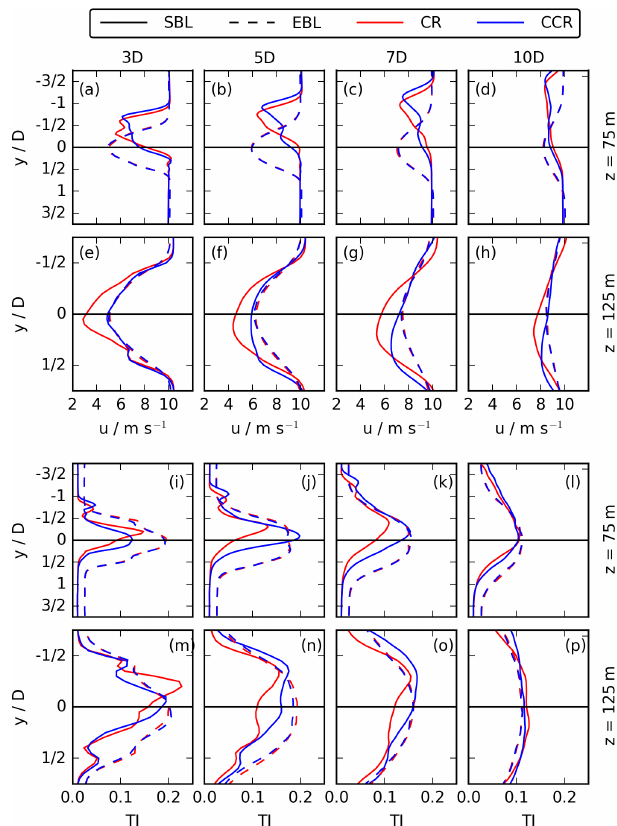
Figure 12. Spanwise profiles of u (first two rows) and TI (last two rows) at z = 75m in the first and third rows and at z = 125m in the second and last rows for the SBL and the EBL wind-turbine simulations at x = 3D (first column), 5D (second column), 7D (third column), and 10D (fourth column) downwind and for both rotational directions CR and